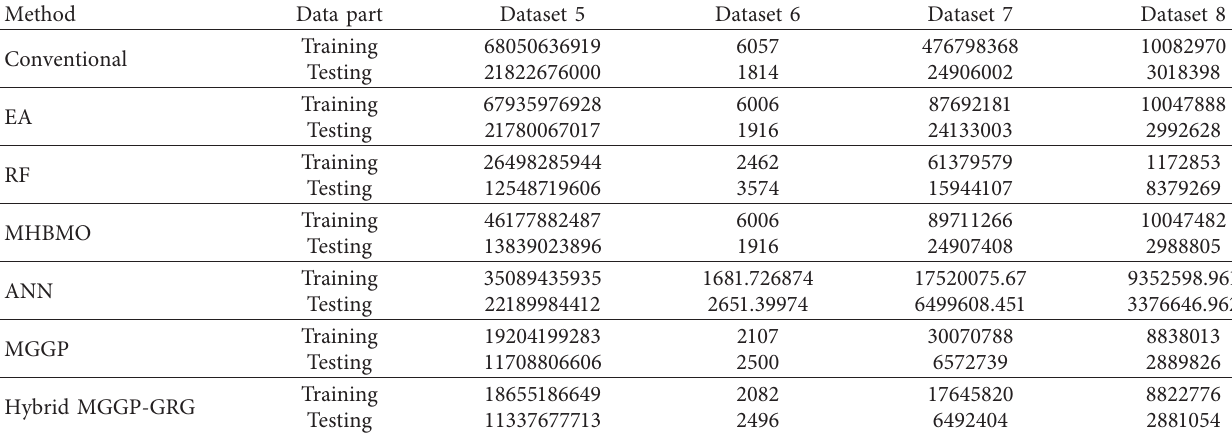
Table 5: Comparing SSE of different methods for developing loop rating